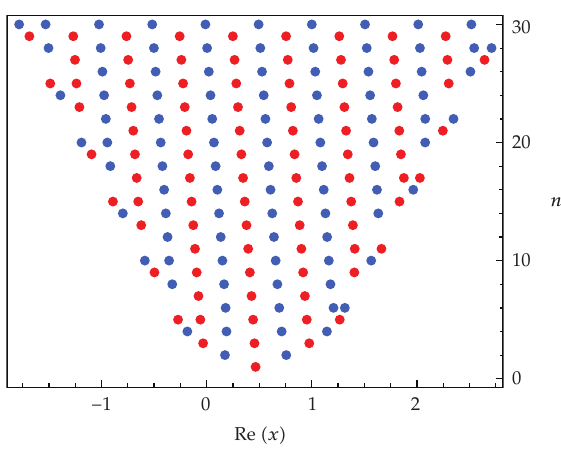
(cid:2) 3 (cid:3) (cid:2) x (cid:3) , q (cid:6) 9 / 10 , 1 ≤ n ≤ 30. n,q